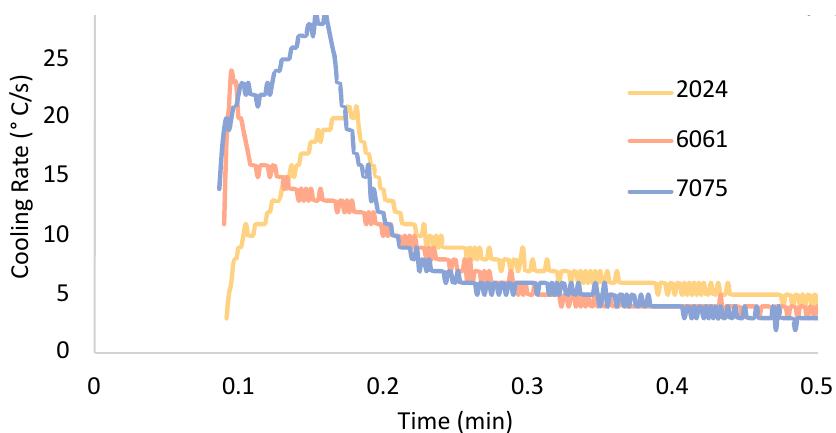
Figure 2. Cooling rate as a function of time for each alloy during casting.